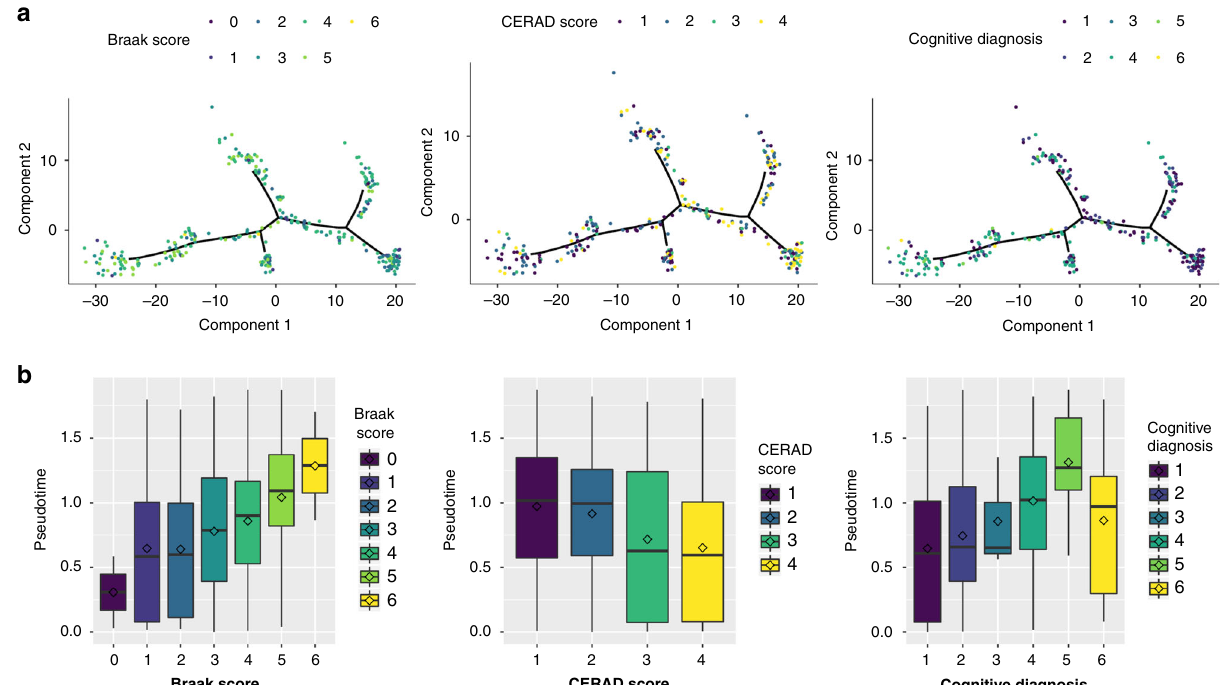
Fig. 3 Manifold learning replicates existing measures of staging in LOAD in DLPFC samples. a Samples colored by three different external measures of LOAD staging, namely: Braak score (tau pathology), CERAD score (amyloid pathology), and cognitive diagnosis (clinical measure of disease severity). Black lines denote inferred lineages. b Distribution of samples by inferred stage for different distinct stages in each of the three methods of measuring LOAD severity for 338 independent samples from one study. Inferred disease stages generally corresponded with all methods, and cognitive diagnosis demonstrated the strongest alignment. Box plots have lower and upper hinges at the 25th and 75th percentiles and whiskers extending to at most 1.5xIQR (interquartile